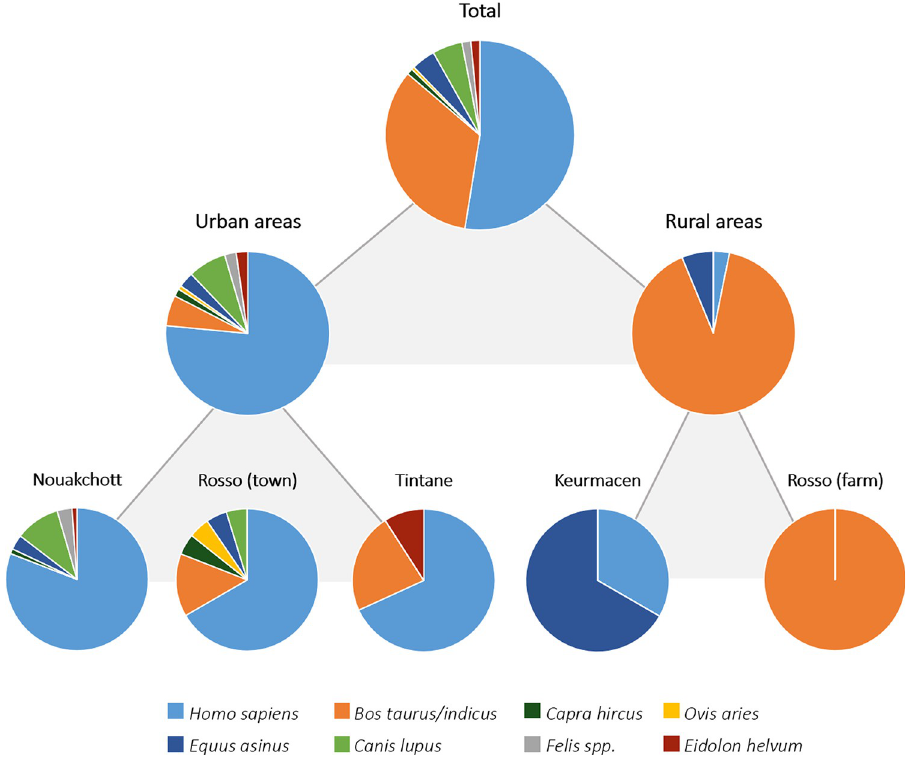
Fig 3. Allocation of blood meal sources. Results of the different sampling sites in the city of Nouakchott are displayed together.